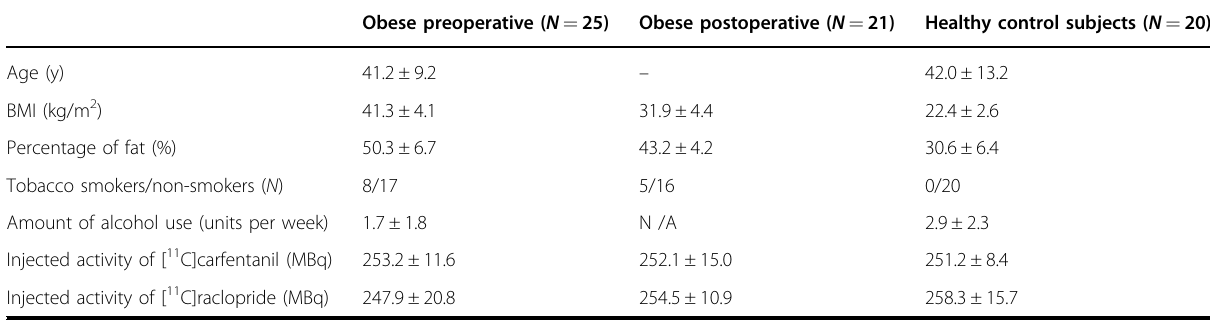
Table 1 Characteristics of the